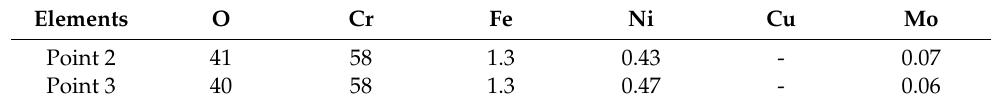
Figure 3. SEM image of inclusions after the polarization ( a ) in 0.1 M NaCl (see Figure 2a) and ( b ) in 0.1 M NaCl-1 mM CuCl 2 (see Figure 2b). Table 3. Relative compositions (at.%) at points 3 and 4 in Figure 3. Elements